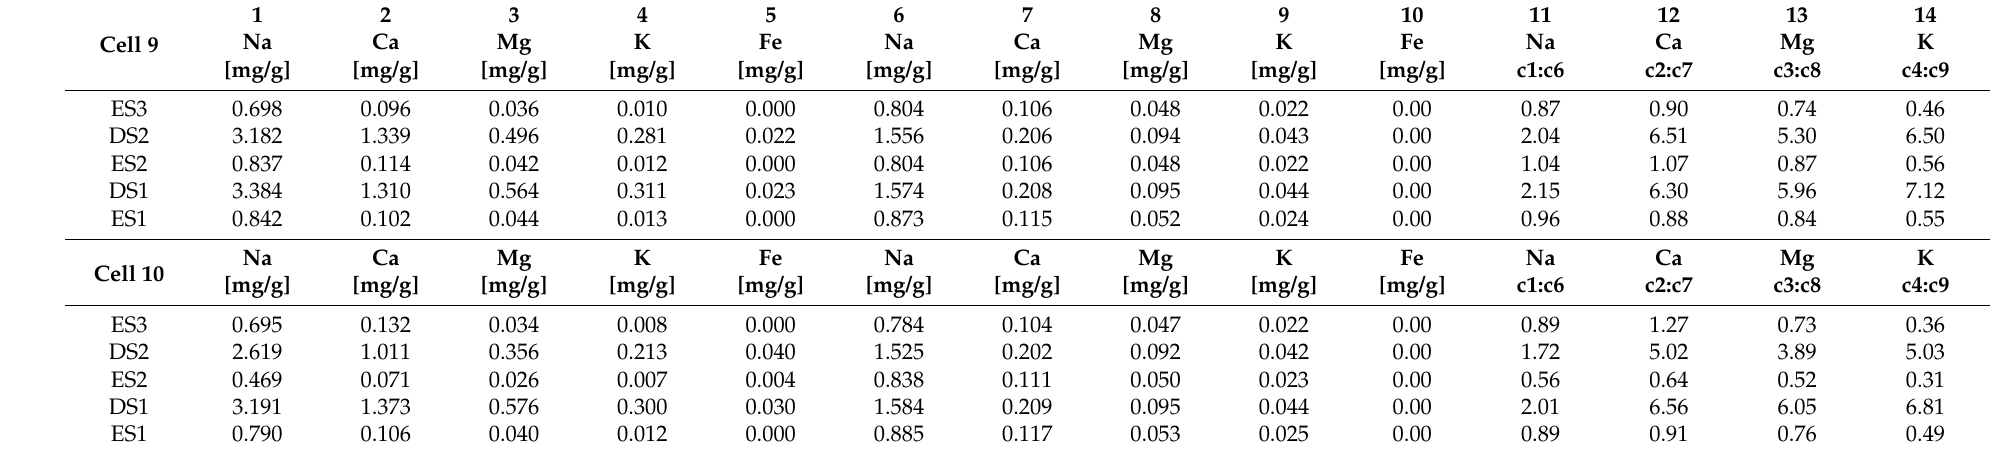
Table 8. Cation concentration in DS and ES after